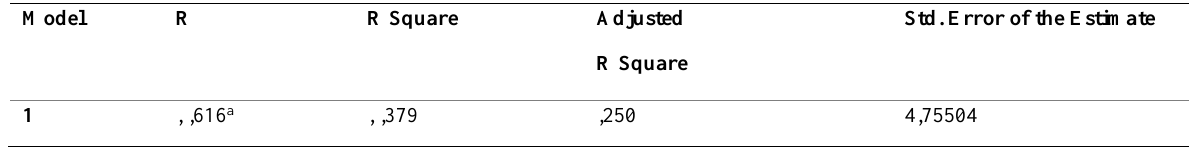
Table 6: Coefficient of Determination